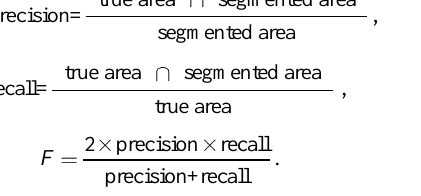
Figure 4. Tracking results of the brown signboard. The frames 3,6,9 and 12 are displayed.